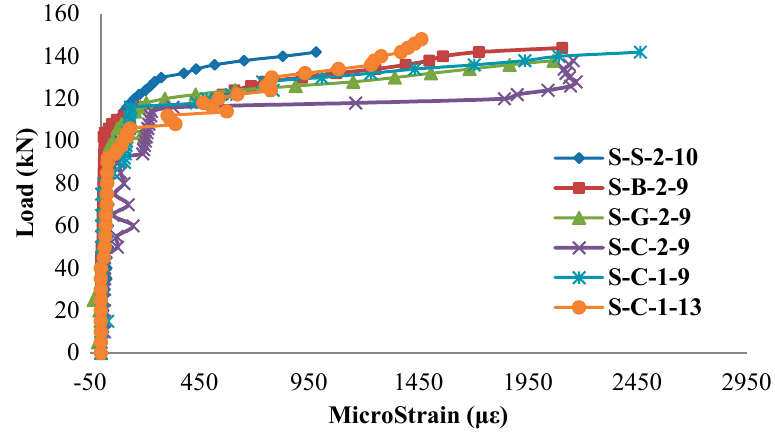
Figure 14. Applied load vs. maximum tensile strain in deep embedment strengthening bars.